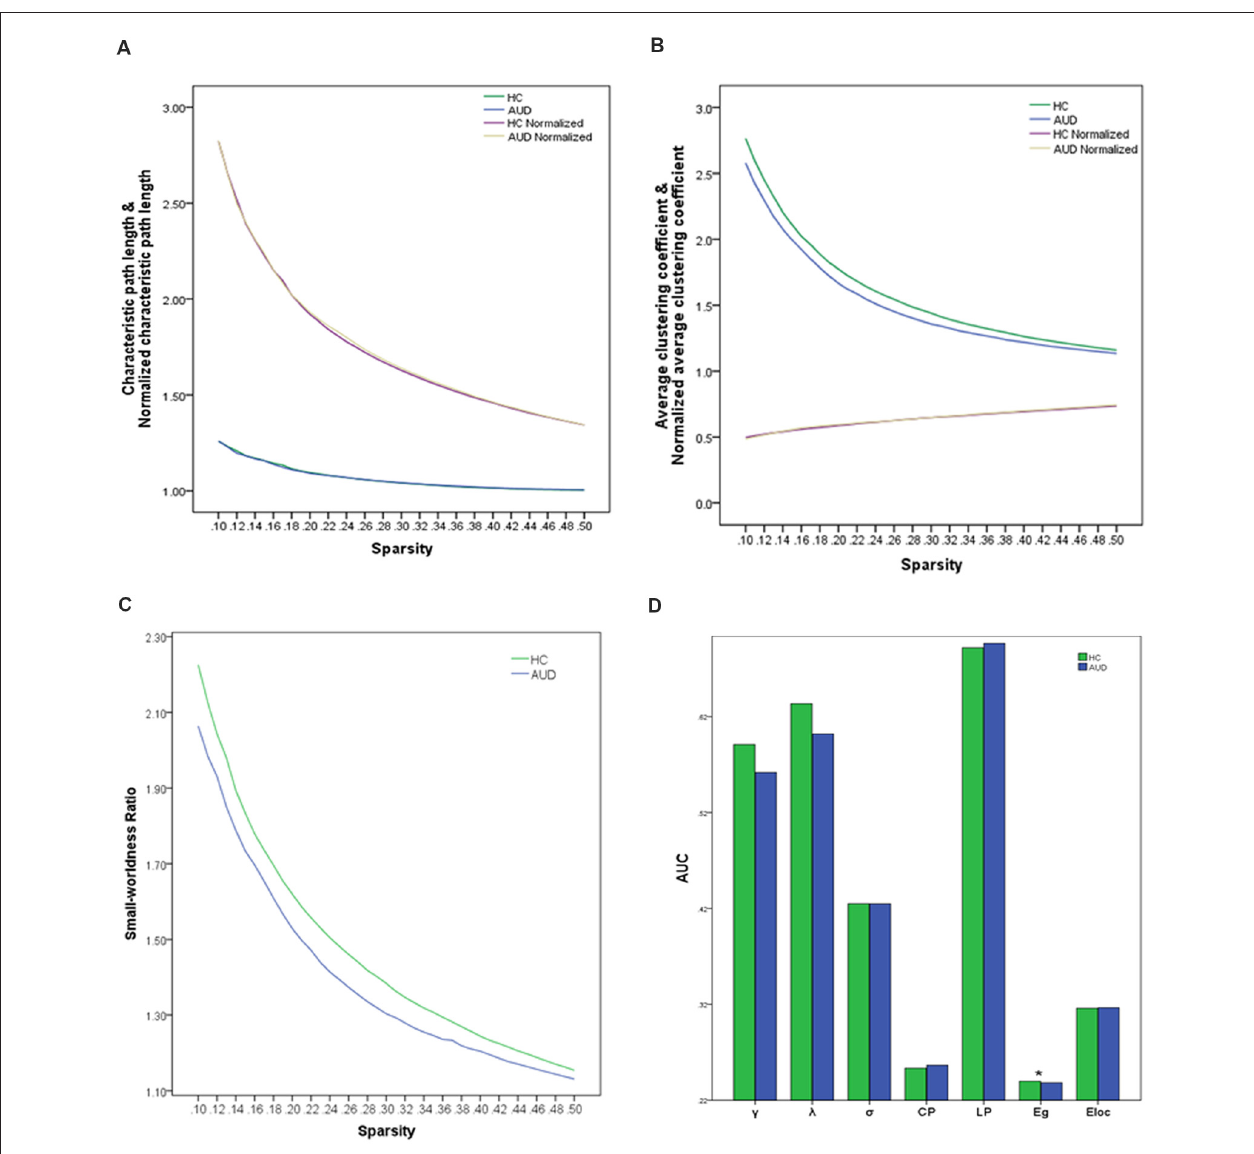
FIGURE 1 | Global topological attributes of brain connectivity between the groups. (A) Characteristic and normalized characteristic path lengths. (B) Average and normalized average clustering coefficients. (C) Small-worldness. (D) AUC of the parameters of seven global topologies in two groups. Significant difference (asterisk) was only found in the Eg AUC in the range of 10%–50% (HCs: 0.240 ± 0.005; AUD: 0.238 ± 0.008; p = 0.023). AUD, alcohol use disorder; HCs, healthy controls; AUC, the area under curve values; Eg AUC , the area under curve values of the global efficiency.